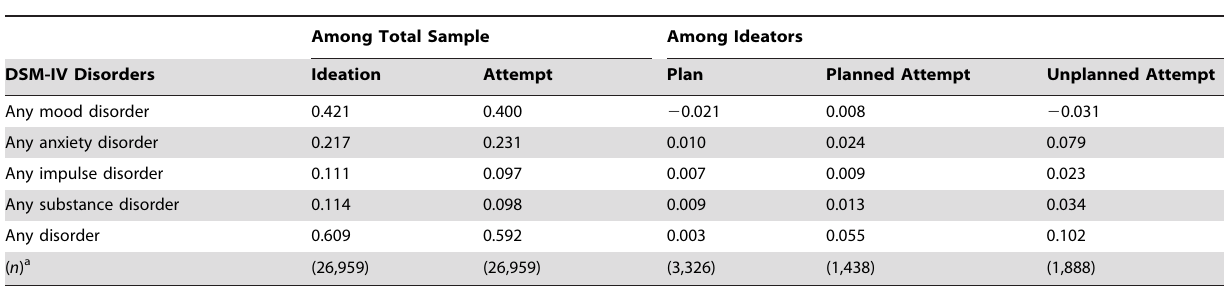
Table 9. PARP of DSM-IV disorders—developing countries.